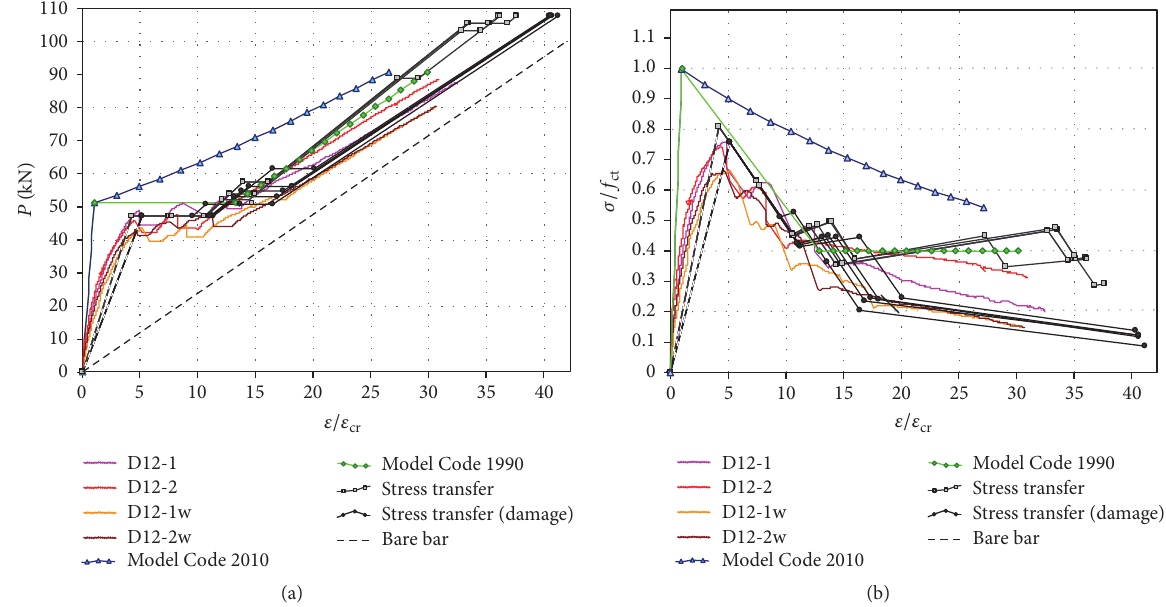
Figure 8: Theoretical modelling of RC ties: (a) load-average strain diagrams; (b) average stress-average strain diagrams.